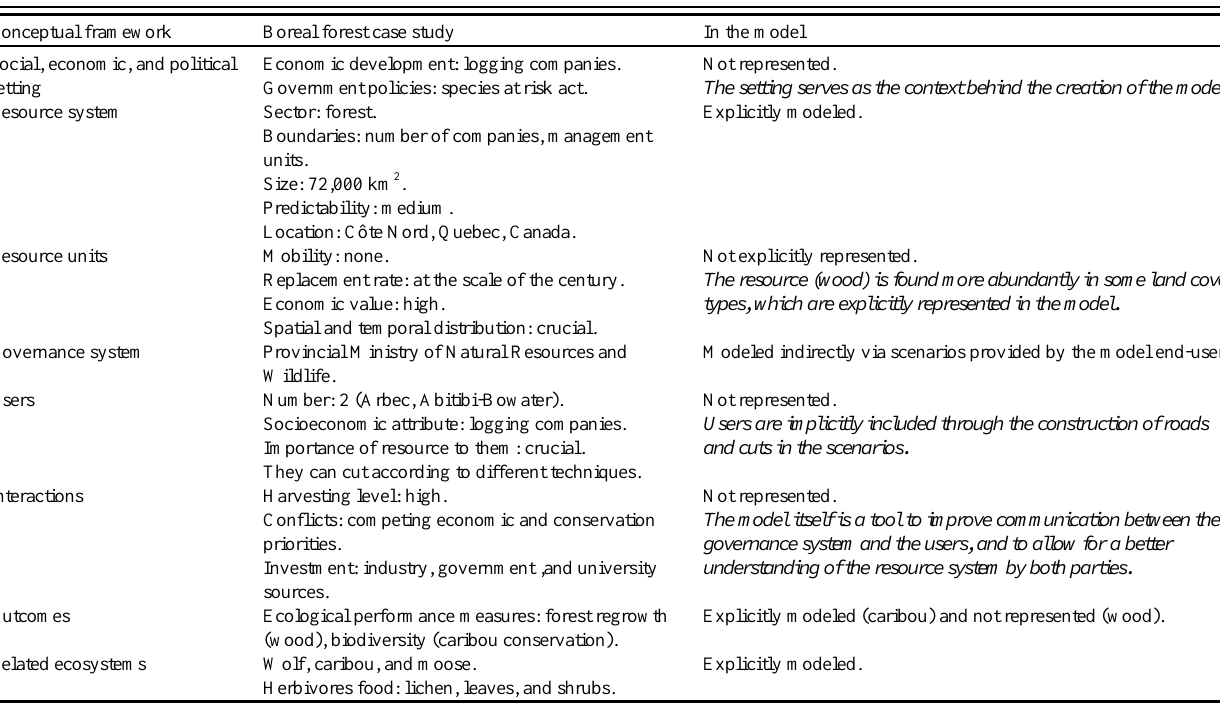
Table 1 . Conceptual framework of case study 1: boreal forest, northeastern